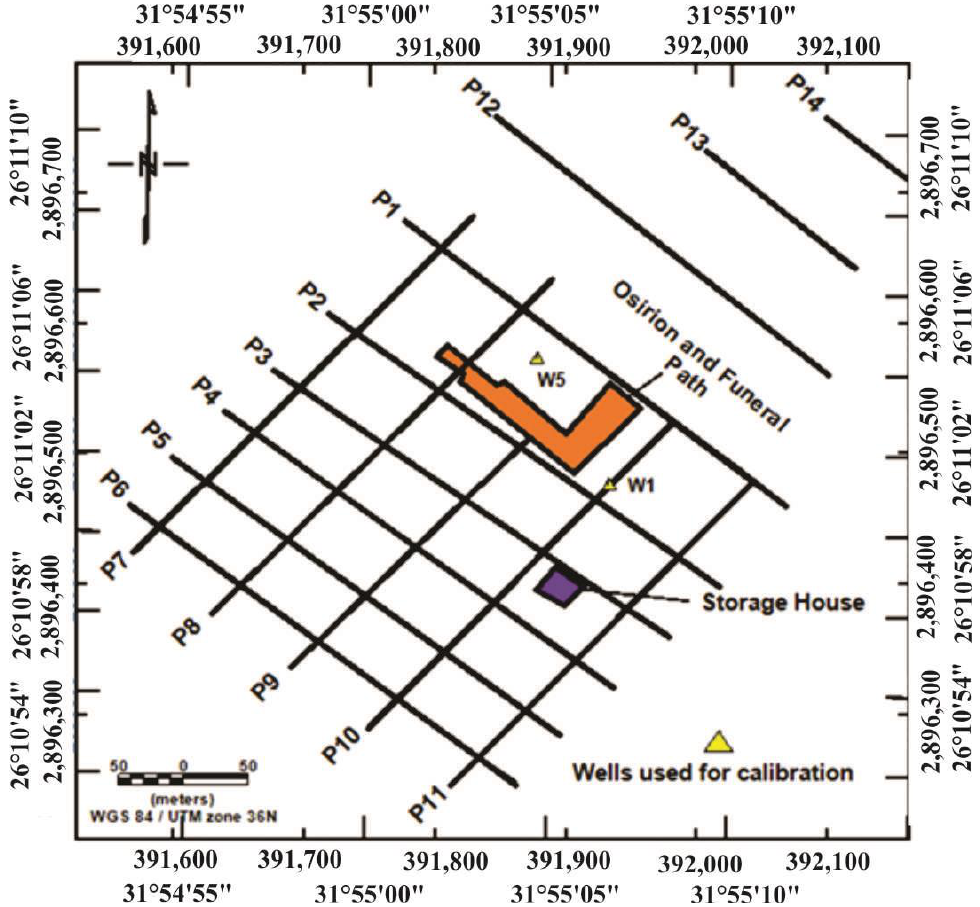
Figure 4. Index map for the surveyed profiles using 2D electrical resistivity tomography, where fourteen ERT profiles were covered at the aimed site. The locations of two available boreholes are also shown.